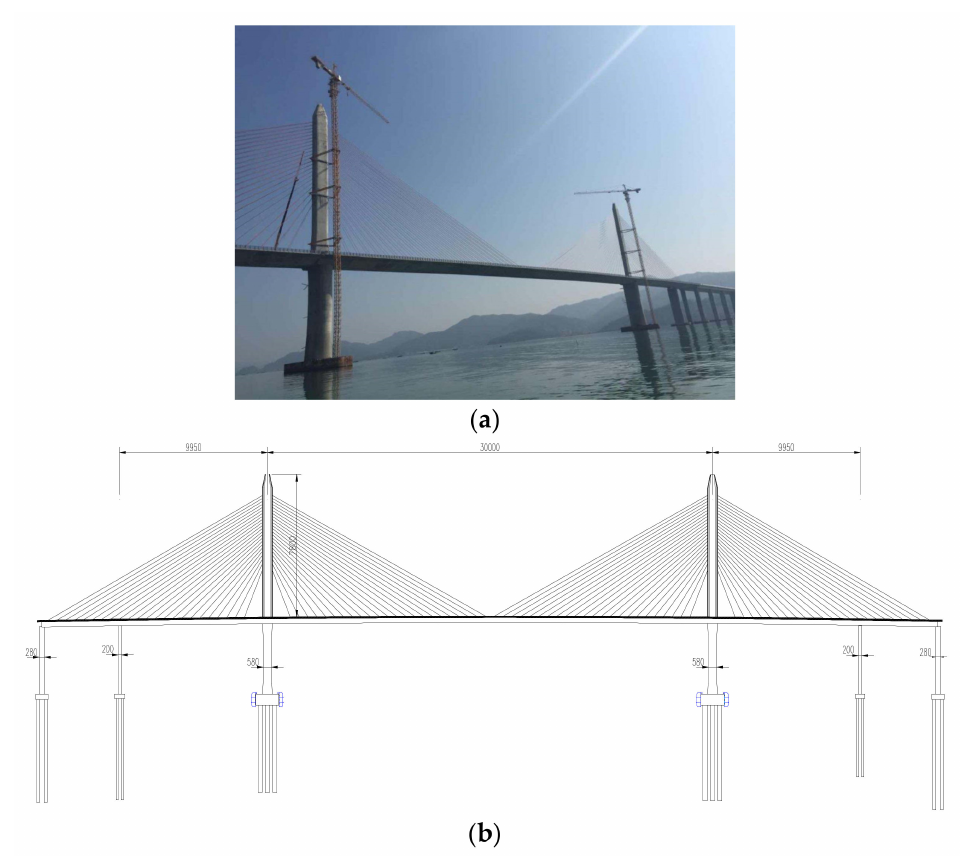
Figure 3. Photo and elevation view of the cable-stayed bridge. ( a ) The side elevation photo of the bridge during construction. ( b ) Elevation view.